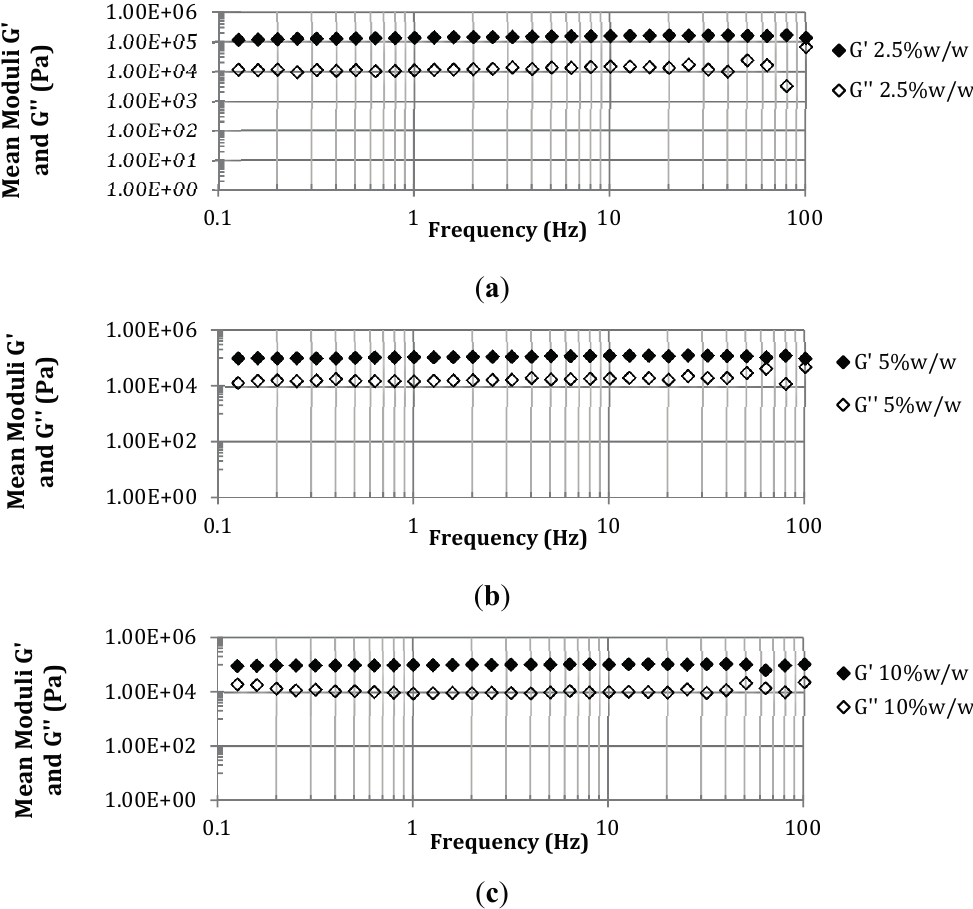
Figure 6. Log–log plot of average shear moduli (elastic (G’) and viscous (G’’)) vs. frequency for PEO hydrogel films containing various PETRA concentrations ( a ) 2.5% w / w , ( b ) 5% w / w , ( c ) 10% w / w . Strain ( γ ) = 0.1 and temperature = 25